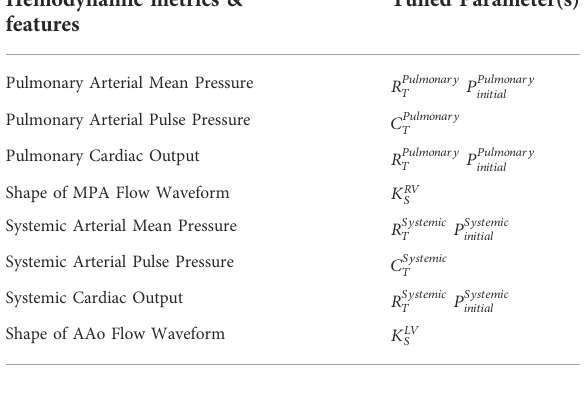
TABLE 2 Hemodynamic metrics and tuned parameters of the high- resolution arterial model. Hemodynamic metrics & features